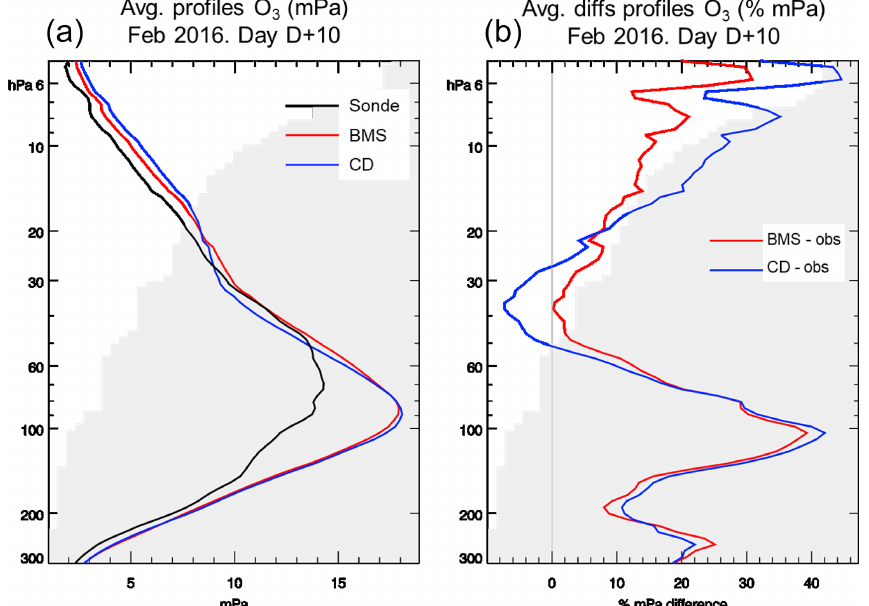
Figure 7. Averaged vertical profiles of ozone (mPa) over the Arctic region in February 2016 (a) from ozonesonde observations (black), from a model run using the new BMS ozone scheme (red) and a model run using the default ozone configuration (blue). The model profiles are for day 10 in the forecast run. The percentage differences in ozone concentrations between the forecast runs and the observations are also shown (b) . Shaded areas indicate the density of observation profiles for the corresponding altitude range for the considered